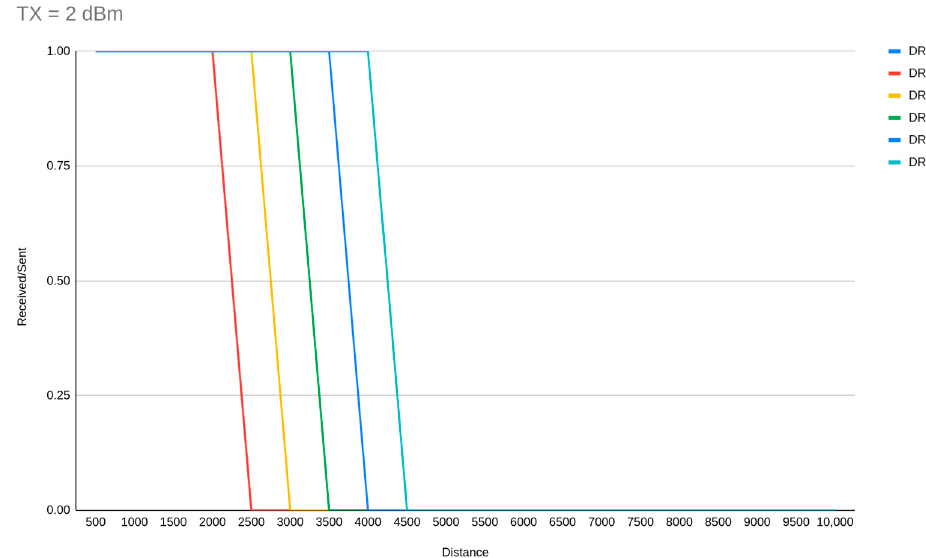
Figure 11. Range of communication with TX power of 2 dBm.